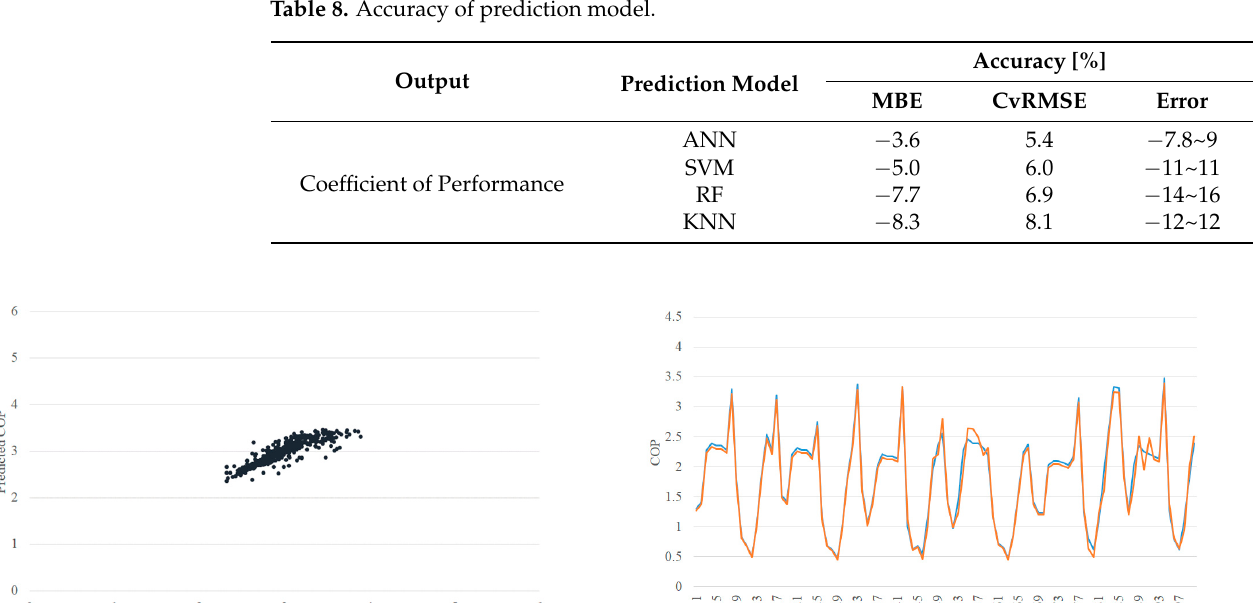
Table 8. Accuracy of prediction model.